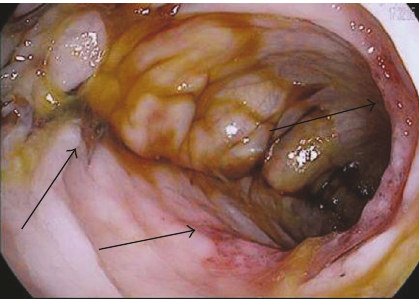
Figure 2: Endoscopic image of the sigmoid colon with areas of mucosal hemorrhage, mucosal friability, and inflammation. demonstrated focal acute inflammation, mucosal hemor- rhage, fibrin, and distorted crypts, consistent with ischemia.